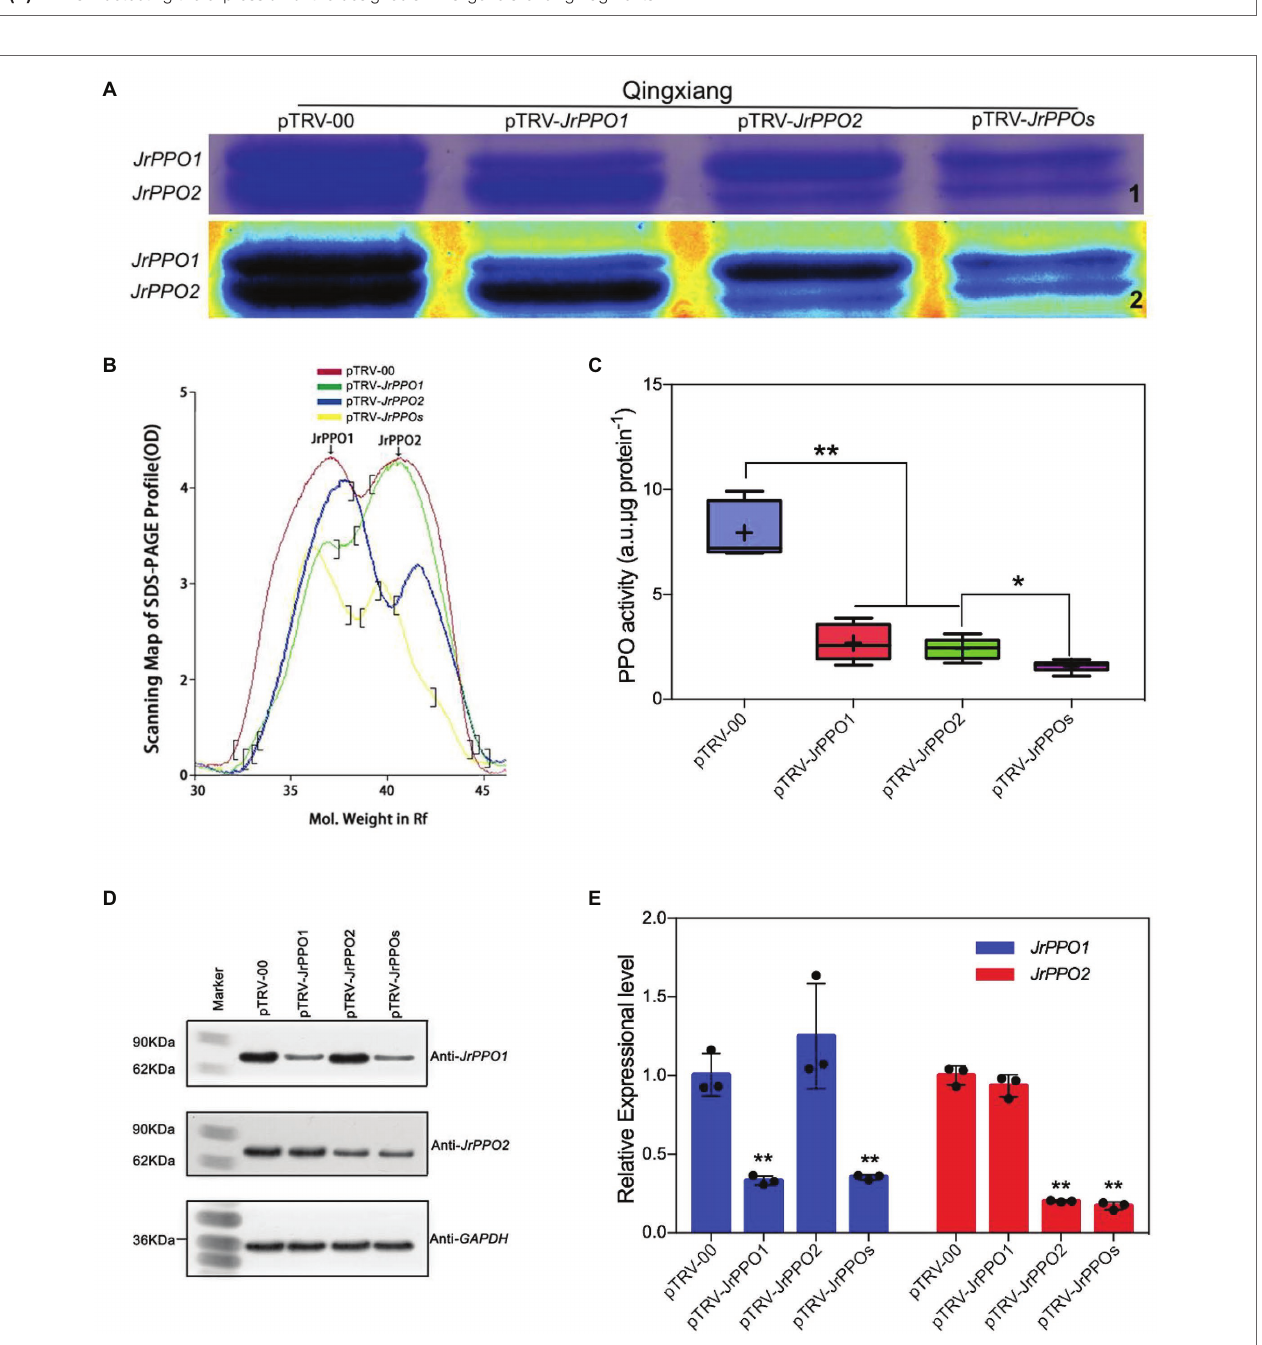
FIGURE 5 | Values were expressed as means ± SD. The asterisks indicate statistically significant differences relative to the control at * p ≤ 0.05 and ** p ≤ 0.01. (D) RT-PCR detecting the expression of the designed JrPPO gene silencing fragments.